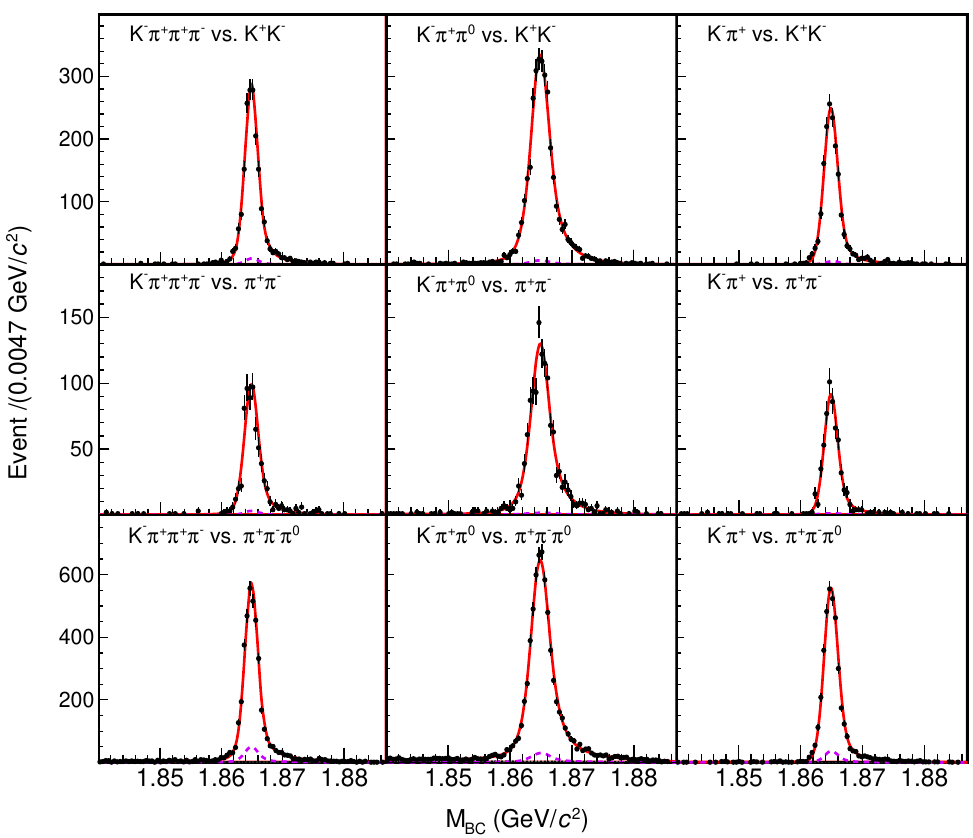
Figure 3 . M BC distributions for a selection of CP -tagged decays. The points with error bars are data; the red line indicates the total fit; the dashed purple line shows the peaking-background contributions; the combinatorial-background contribution is at too low a level to be